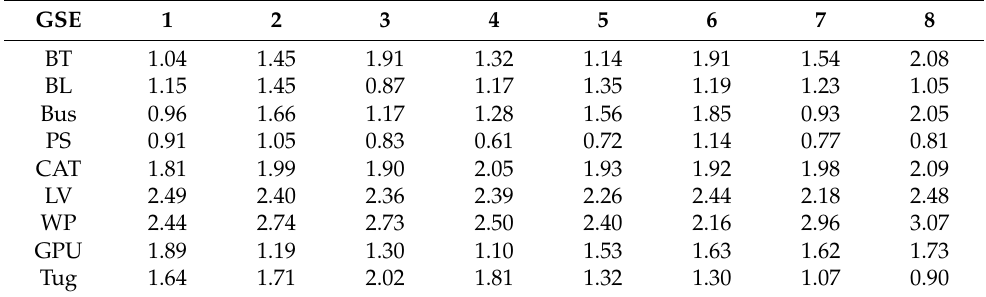
Table 8. Average covered kilometers per vehicle.